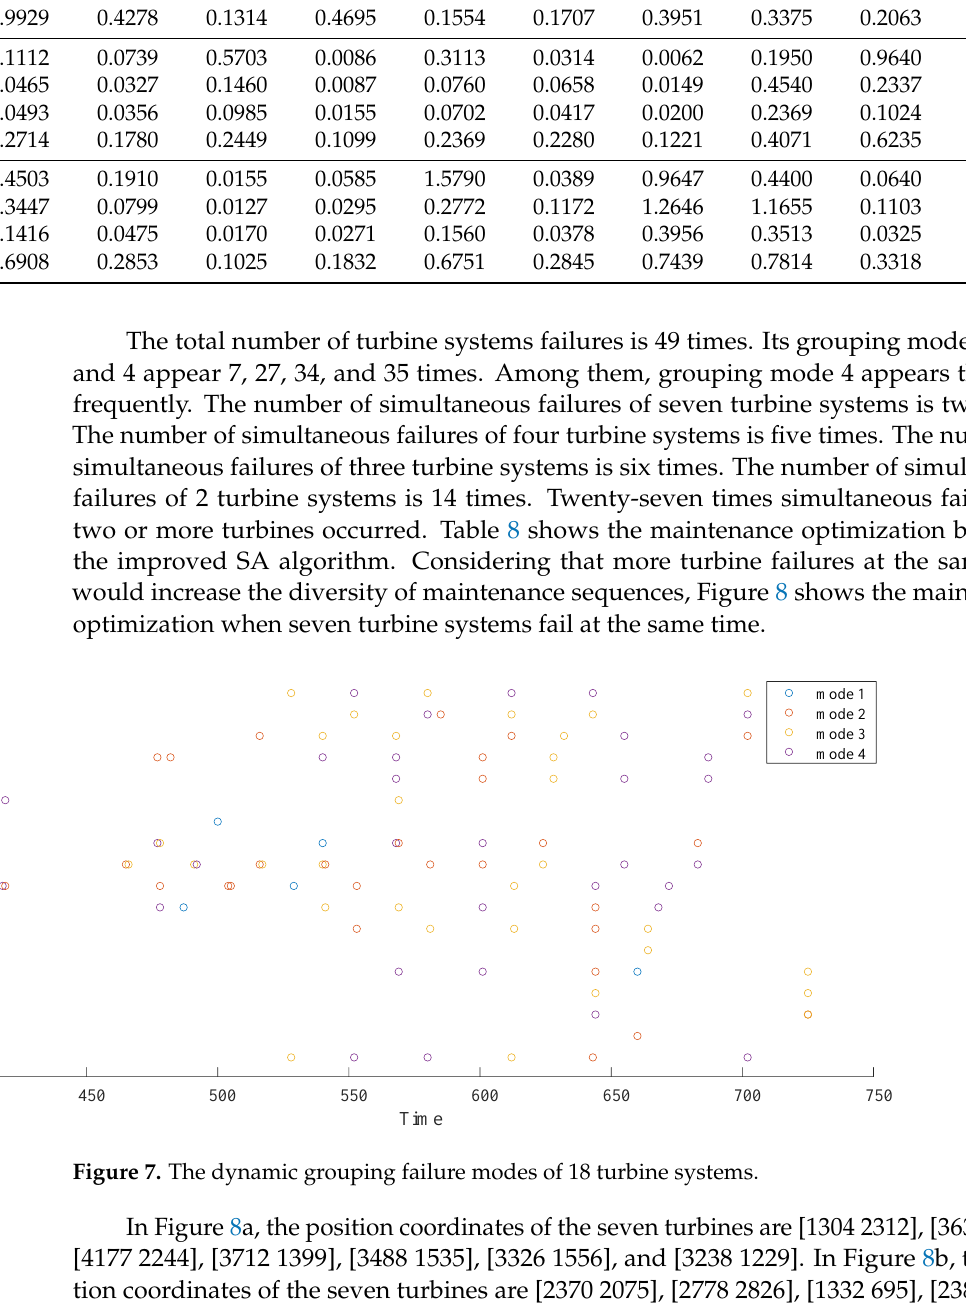
Figure 8. The maintenance optimization when 7 turbine systems fail at the same time. ( a ) The maintenance sequence for turbines is 10, 11, 8, 5, 1, 15, and 14. ( b ) The maintenance sequence for turbines is 12, 9, 5, 8, 3, 4, and 7. In Figure 8a, the position coordinates of the seven turbines are [1304 2312], [3639 1315], [4177 2244], [3712 1399], [3488 1535], [3326 1556], and [3238 1229]. In Figure 8b, the position coordinates of the seven turbines are [2370 2075], [2778 2826], [1332 695], [2381 1676], [2788 1491], [3639 1315], and [3238 1229]. Figure 9 is the fitness evolution curve of optimizations. It shows the process of the improved SA algorithm searching for the opti- mal maintenance sequence. In Figure 9a,b, the optimal solutions are obtained when the number of iterations is not more than 500 and not more than 300. This shows that the improved SA algorithm is suitable for maintenance sequence optimization.